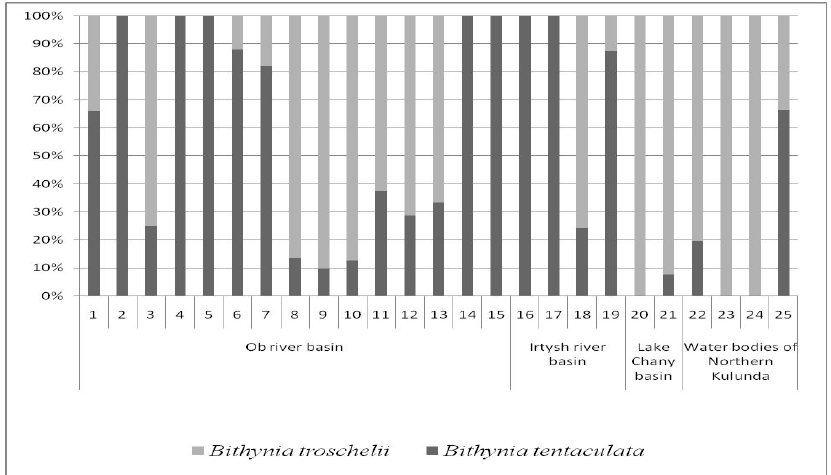
Figure 4. Bithyniid snail abundance (ind.·m − 2 ) in different water bodies of the Novosibirsk region. Abundance of bithyniid snails.